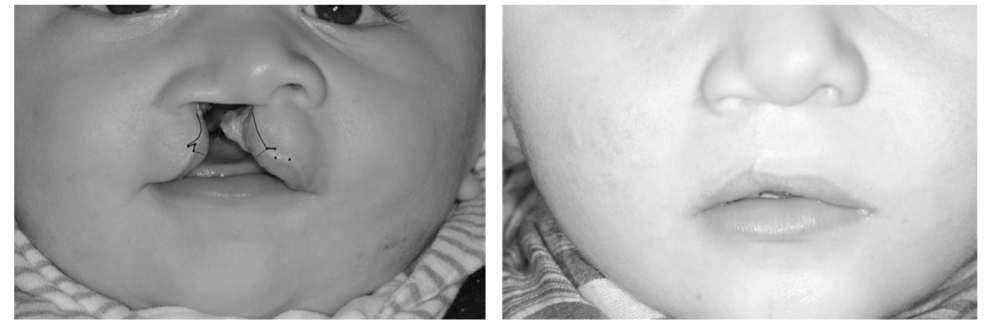
Figure 2. To show the lip markings with reference to Randall’s technique